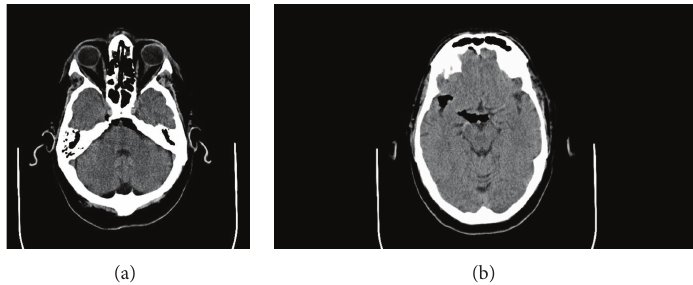
Figure 2: Noncontrast CT scan of the brain displaying significant pneumocephalus exerting slight mass effect on the pons.